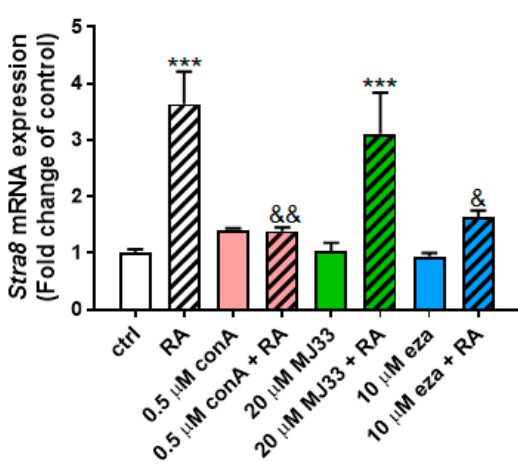
Figure 7. E ff ects of trans-retinoic acid (RA) and PRDX inhibitors on PND3 gonocyte di ff erentiation. RA (1 µ M) and PRDX inhibitors at the indicated concentrations were added alone or together for two hours on gonocytes. Stra8 mRNA expression was measured by qPCR analysis. Results represent the means ± SEM from three experiments. Statistical significance: *** p ≤ 0.001, treatment against control; & p ≤ 0.05, && p ≤ 0.01, treatment against RA alone.